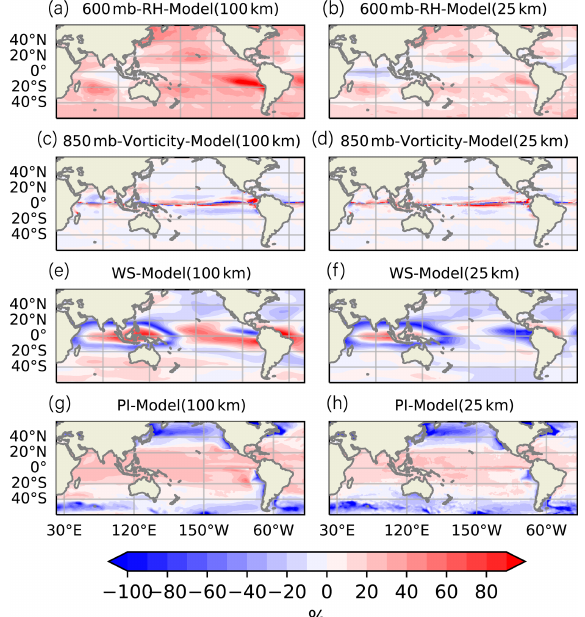
Figure 11. Biases in the large-scale environmental factors related to tropical cyclone activity between FGOALS-f3 and the observations. (a, b) Relative humidity biases at 600hPa; (c, d) absolute vorticity biases at 850hPa; (e, f) wind shear biases between 200 and 850hPa; and (g, h) potential intensity biases.